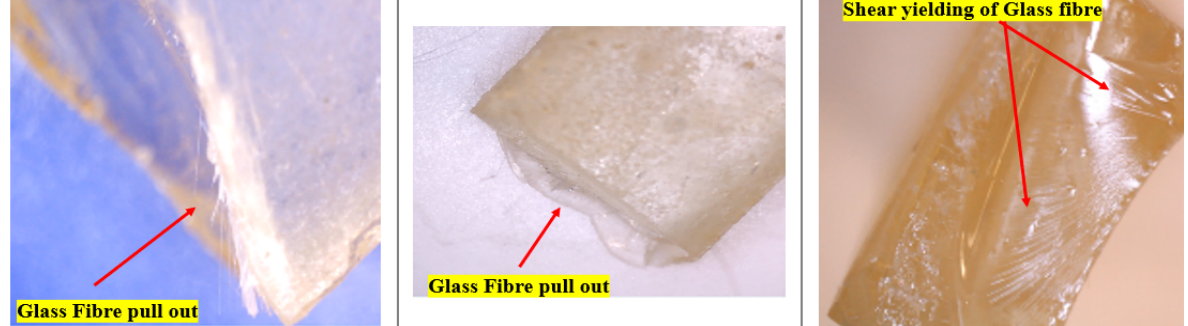
Figure 20. Microstructural images of the GFRE composite samples.